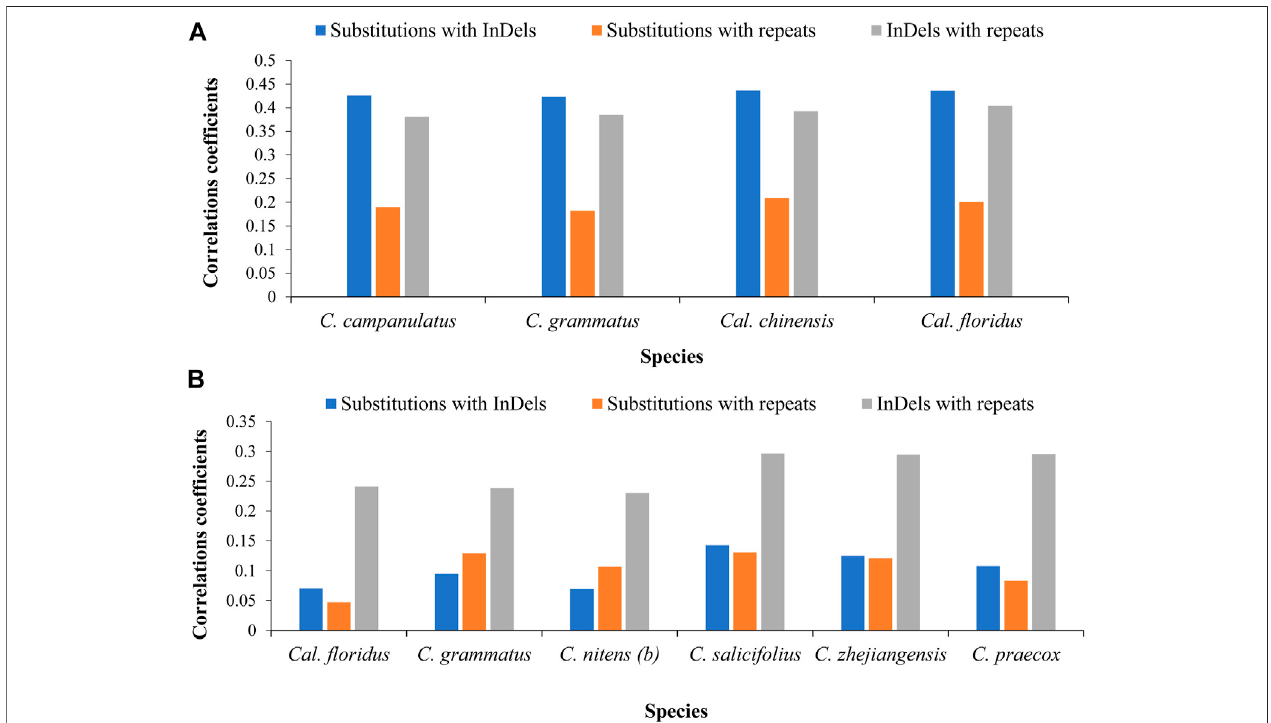
FIGURE 3 | Correlations among mutational events at family and genus levels. (A) Correlations among distinctly related species of family level. The chloroplast genome of Idiospermum australiense was used as reference for all comparisons. (B) Correlations among closely related species at genus level. The Calycanthus chinensis was used as reference in comparison of two species of Calycanthus , whereas the cp genome of Chimonanthus campanulatus was used as reference for all species of Chimonanthus . The x-axis shows name of the species, whereas the y-axis shows the value of correlations coef fi cient.